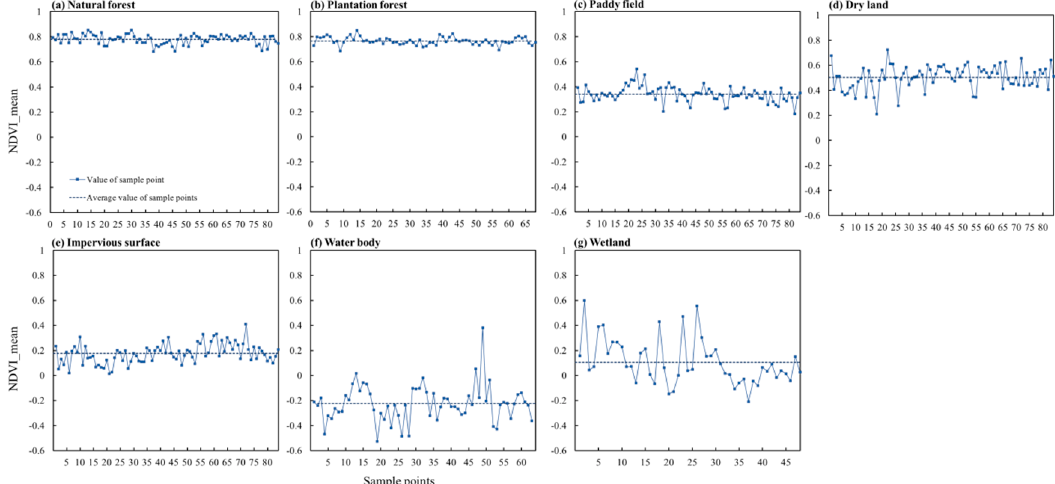
Figure 2. Mean of the annual time-series NDVI (NDVI_mean) for ( a ) natural forest, ( b ) plantation forest, ( c ) paddy field, ( d ) dry land, ( e ) impervious surface, ( f ) water body, and ( g ) wetland.